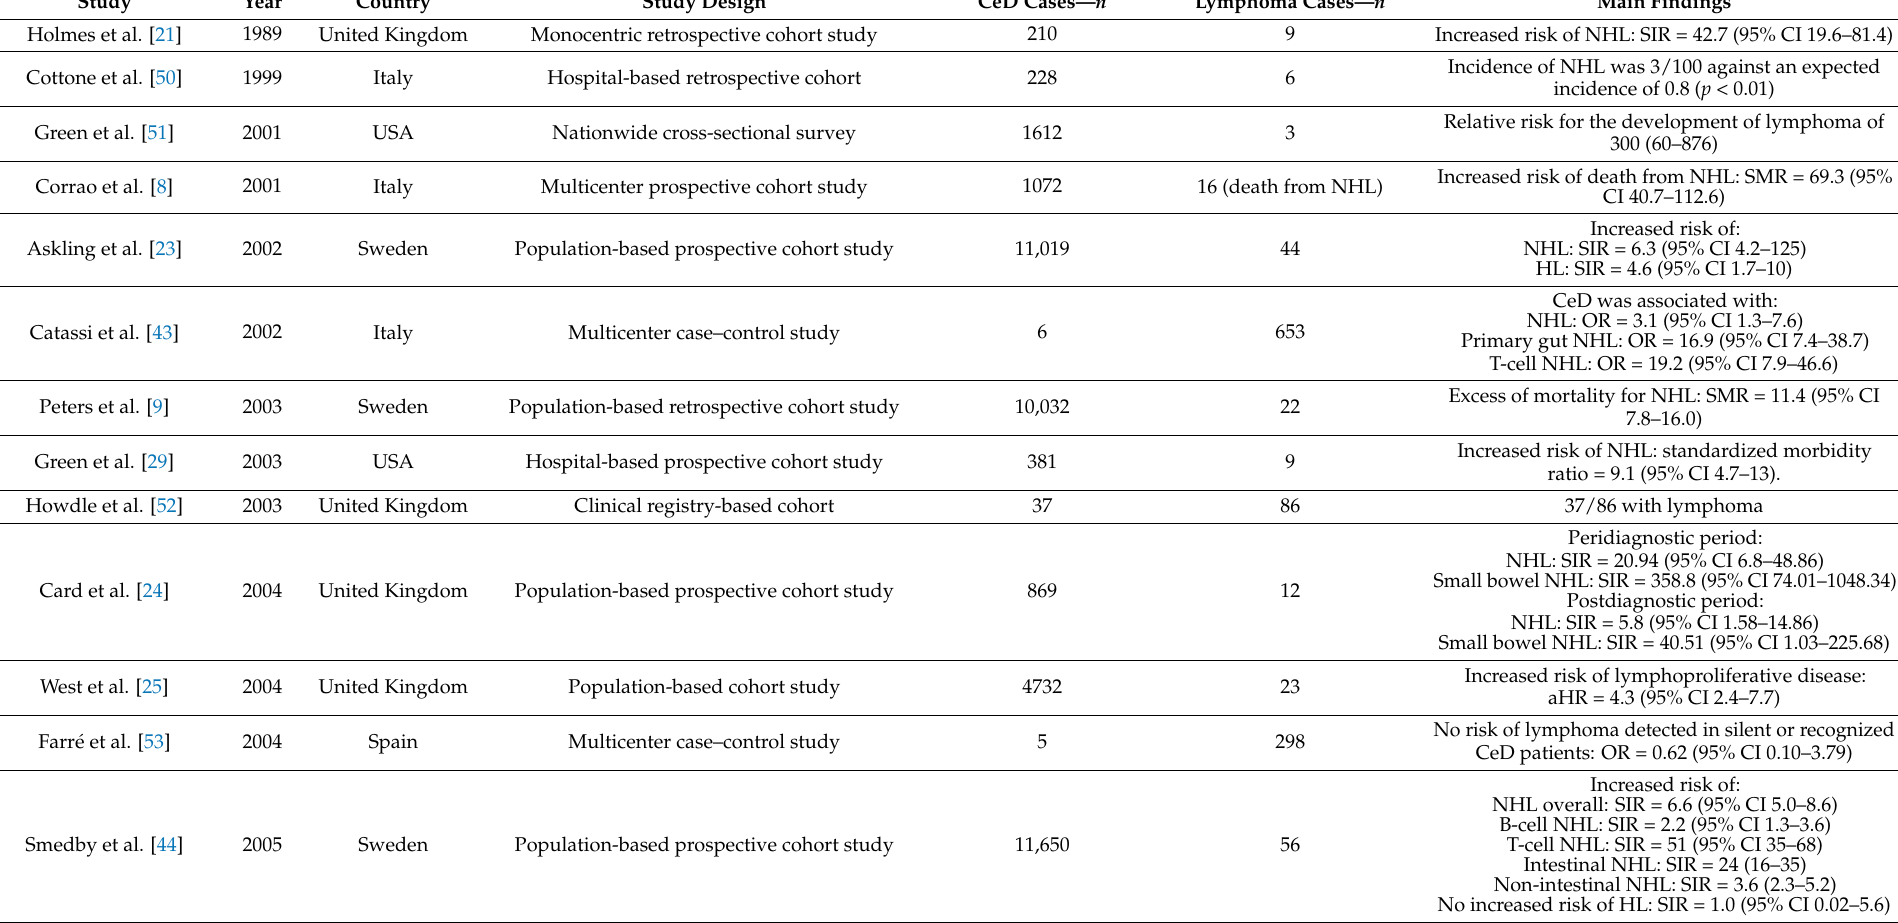
Table 1. Studies investigating the association between CeD and the risk of lymphoma and lymphoma-associated